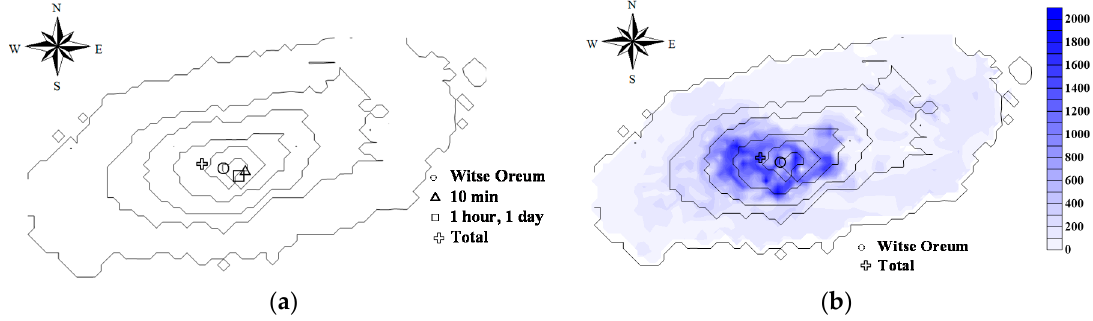
Figure 11. Locations of maximum rainfall depths for several durations ( a ) and the spatial distribution of total rainfall depth during the Typhoon Nakri ( b ). Table 2. Comparison of maximum rainfall depths recorded by rain gauge and radar for several rainfall